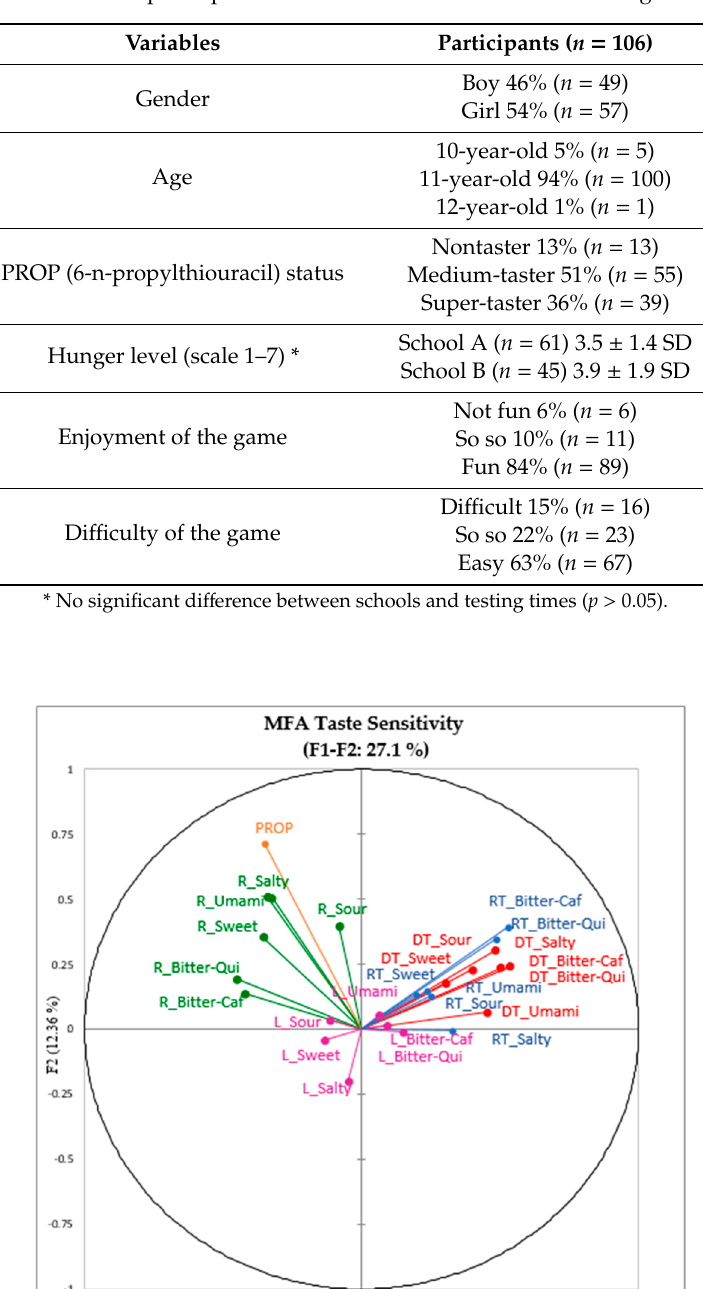
Table 3. The participants’ characteristics and evaluation of the game.